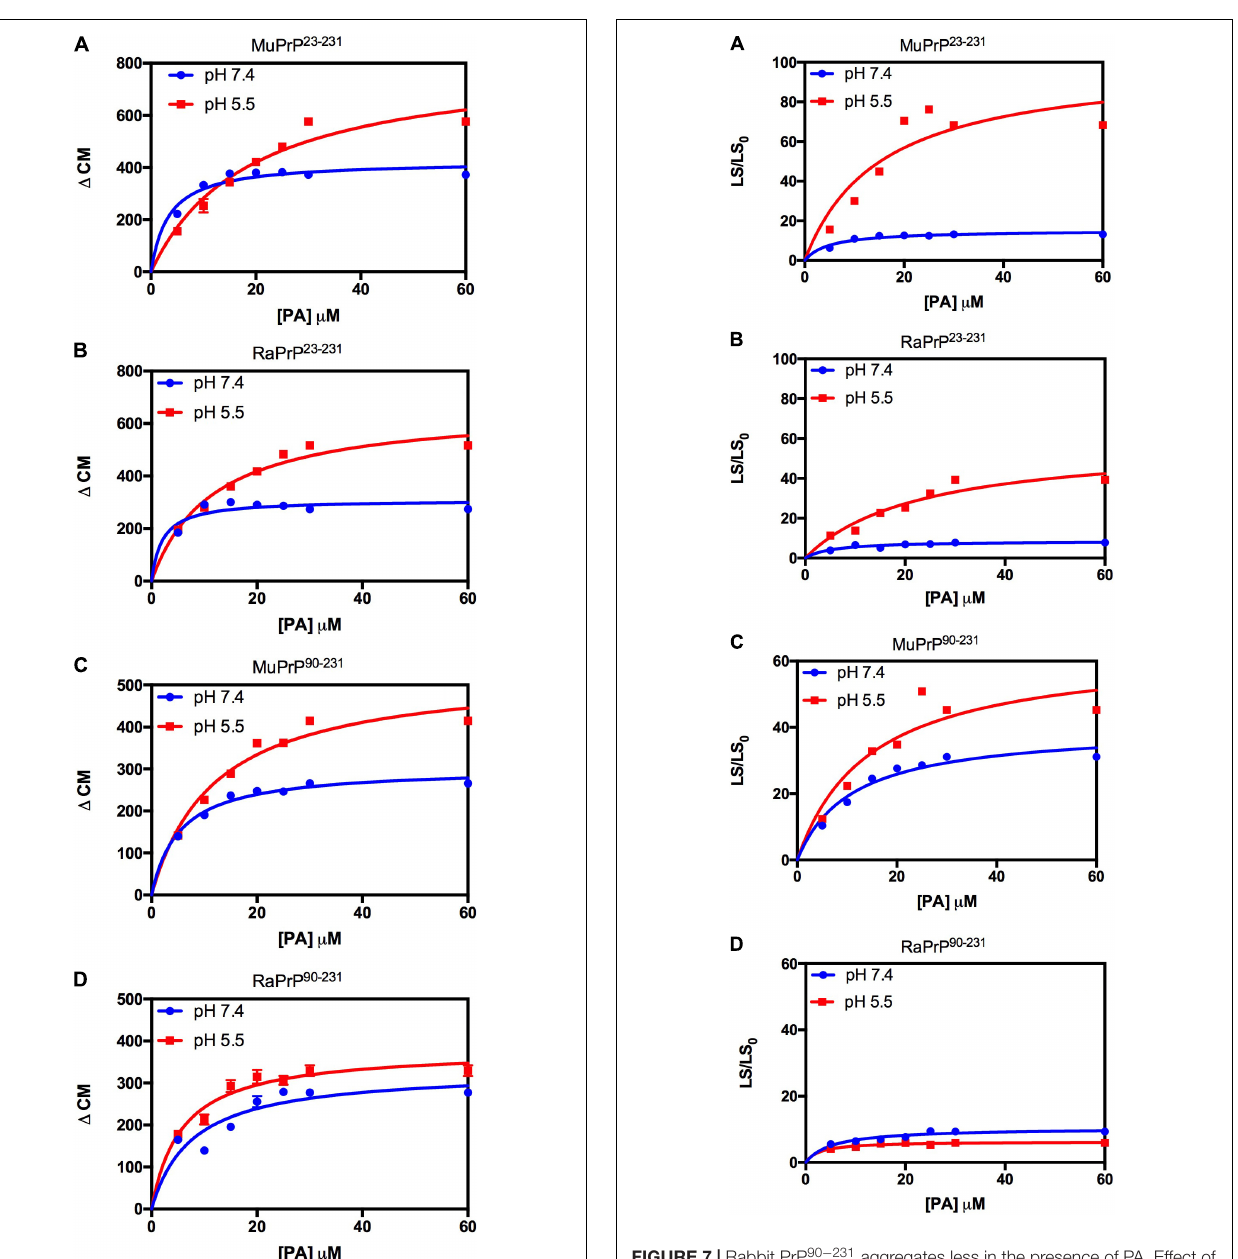
FIGURE 7 | Rabbit PrP 90 − 231 aggregates less in the presence of PA. Effect of increasing the concentration of PA on the relative light scattering of MuPrP 23 − 231 (A) , RaPrP 23 − 231 (B) , MuPrP 90 − 231 (C) , and RaPrP 90 − 231 (D) at pH 5.5 (red) and 7.4 (blue). All proteins were at 2 µ M. The experiments were performed in 50 mM Tris buffer containing 100 mM NaCl at pH 7.4 or in 20 mM sodium acetate buffer containing 100 mM NaCl at pH 5.5. All experiments were performed at 25 ◦ C. The error bars represent the standard deviation of at least two independent